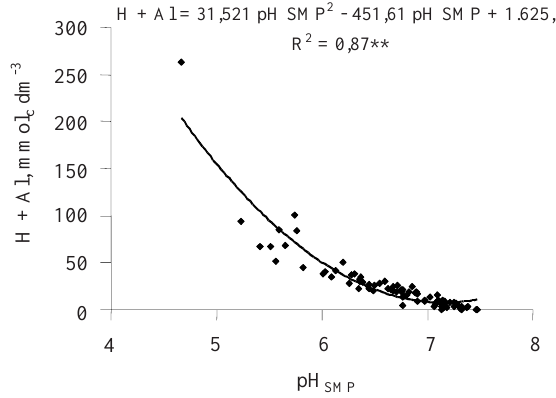
Figura 1. Relação entre a acidez potencial (H + Al) e o pH SMP, em solos do Semi-Árido do Nordeste